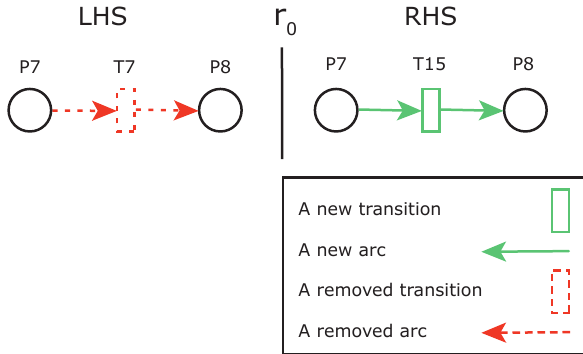
Figure 16. A GRR to replace the compression